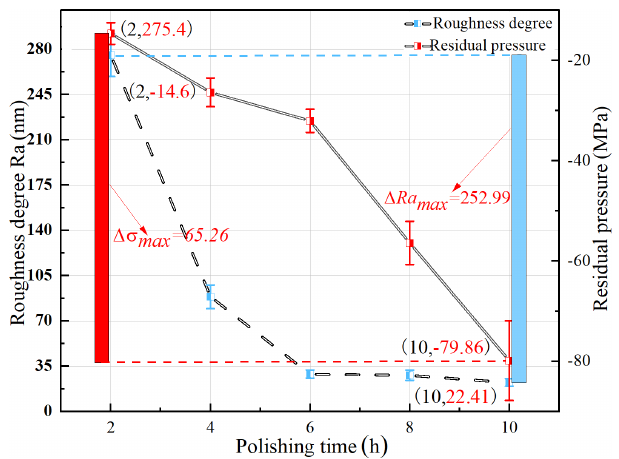
Figure 13. Relationship between time and surface roughness and residual